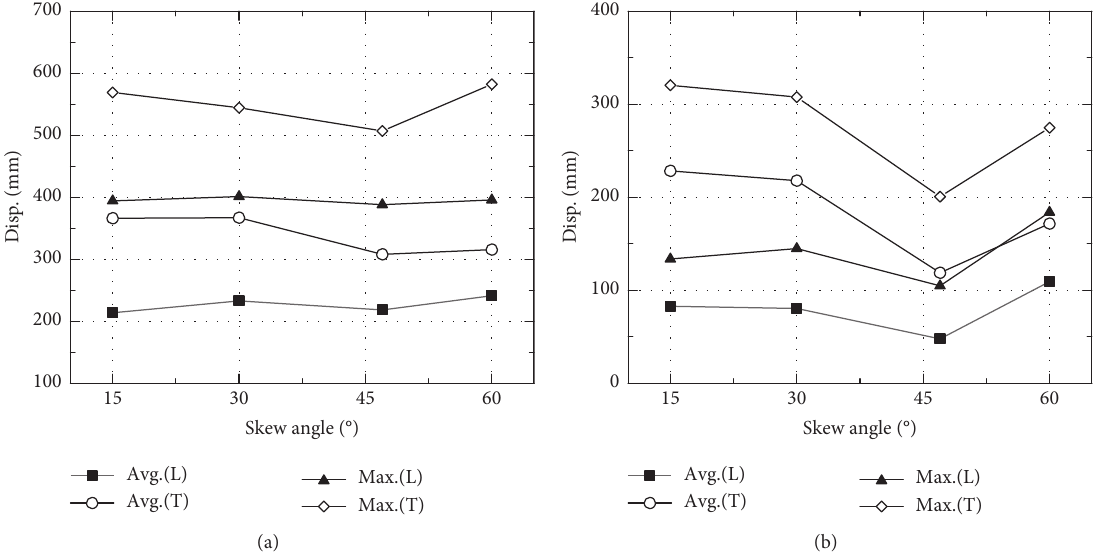
Figure 16: Comparison of seismic displacements of bearings with different skew angles. (a) Maximum displacement. (b) Residual displacement.